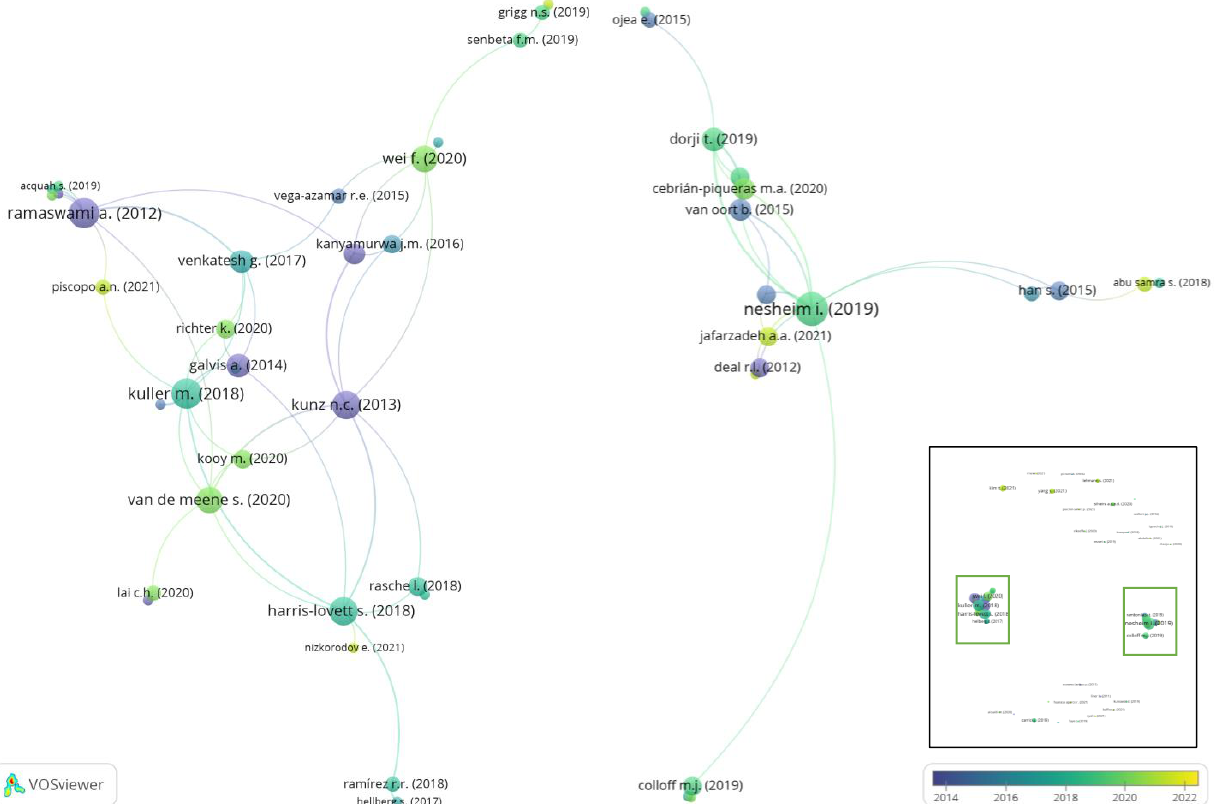
Figure 10. Network of selected articles according to reference coupling. Data from Scopus, visualizing adapted from VOSviwer 1.6.18 [37 – 102].